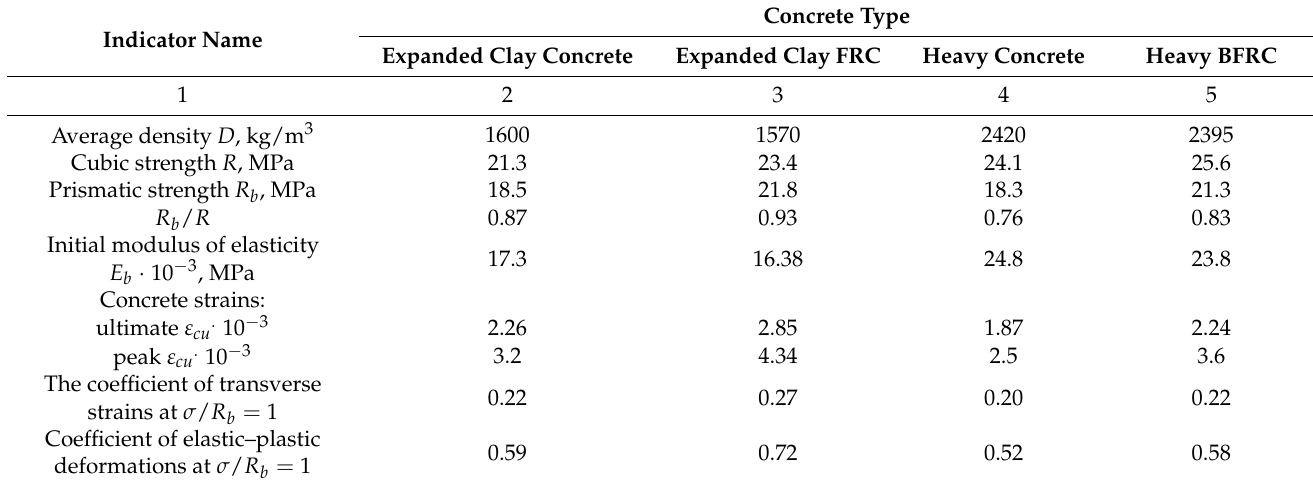
Table 7. Results of short-term tests of prisms with a size of 10 × 10 × 40 cm from light and heavy BFRC for axial